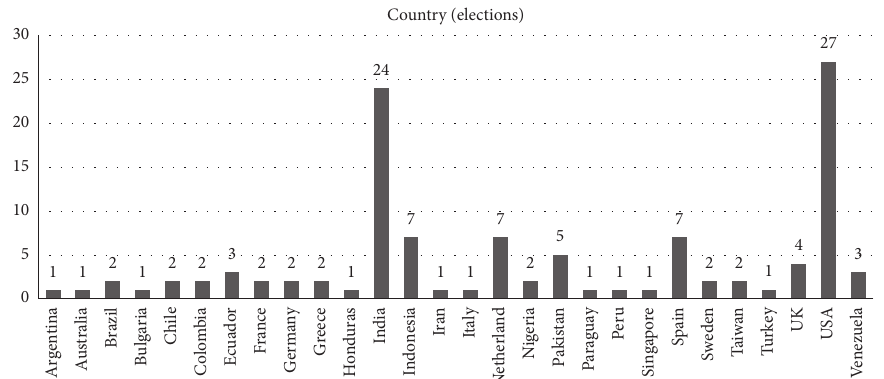
Figure 11: Countries included in reported papers for election prediction.